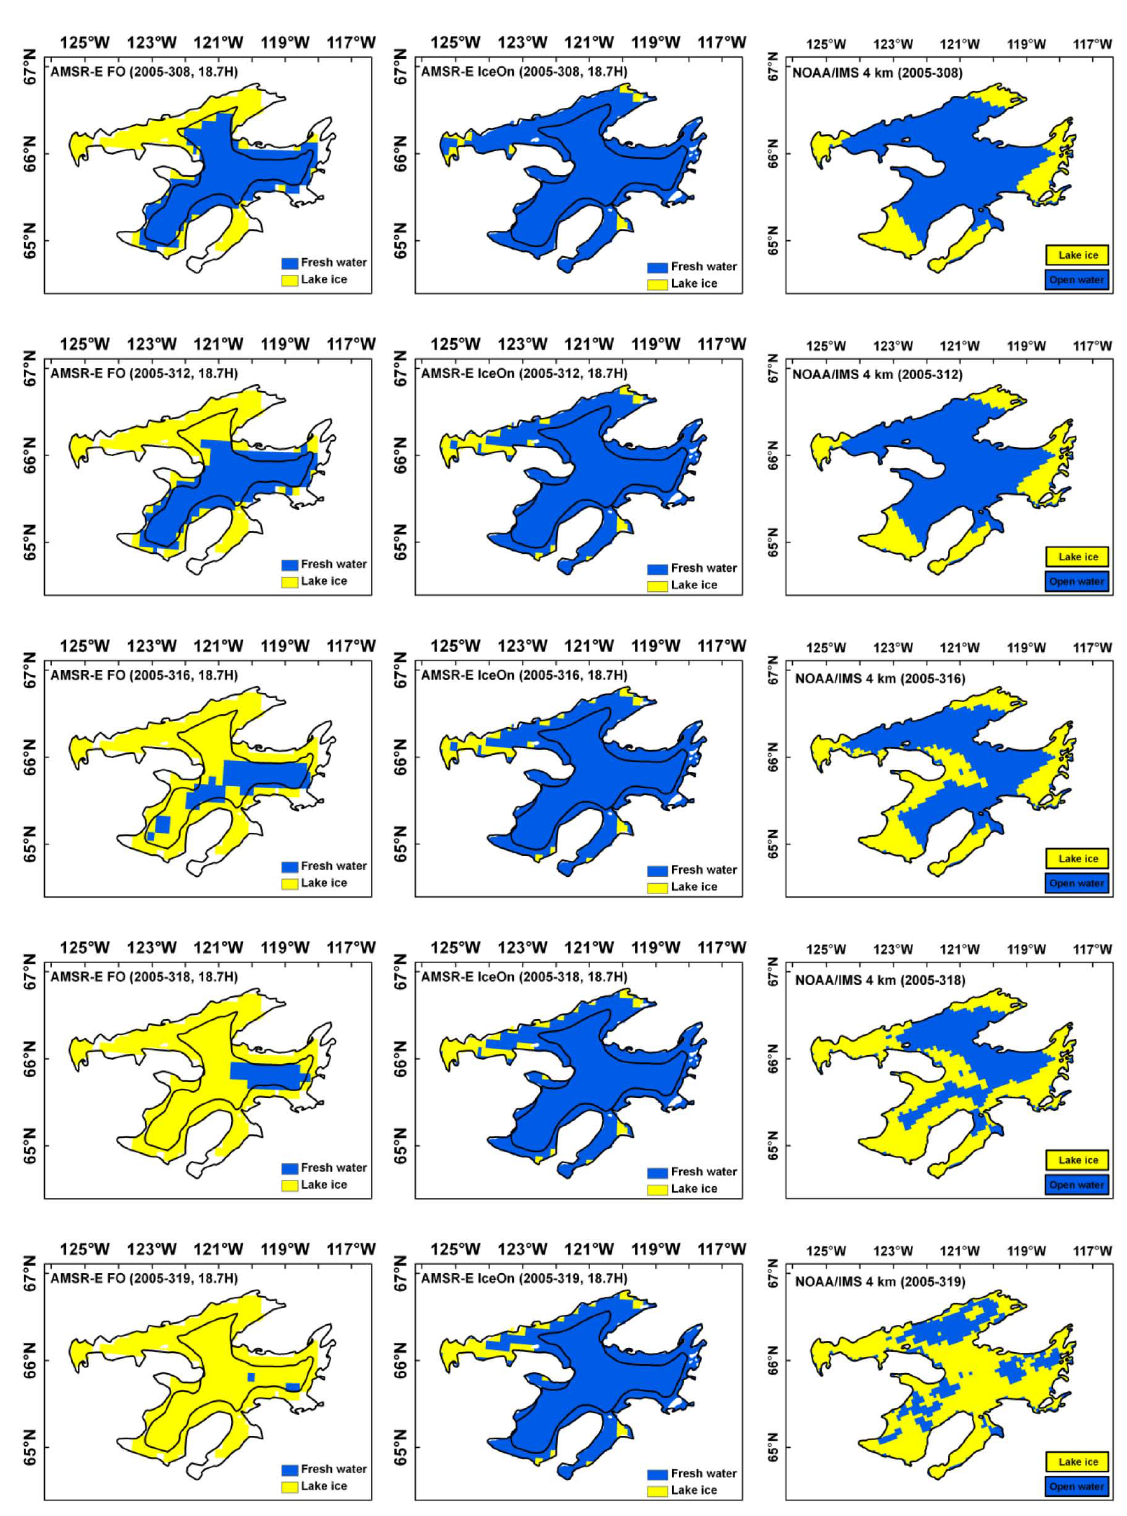
Fig. 6. Comparison of AMSR-E freeze-onset (left), ice-on (center), and NOAA/IMS ice-on (right) (day of year) during the freeze-up period of ice season 2005–2006 on